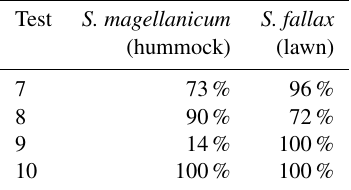
Table 4. Result from tests 7–10, which addressed the importance of meteorological fluctuations, the stochasticity of model parameters, and the photosynthetic water response. In Test 7, monthly mean val- ues of meteorological variables were used to drive the model simu- lation. In Test 8, the stochasticity of model parameters was removed, and the average values were used for parameters at the grid-cell level. In tests 9 and 10, the photosynthetic water-response parame- ters (i.e. a W0 , a W1 , and a W2 ; see Table 1) were set to be the same as those for S. magellanicum (Test 9) or the same as those for S. fallax (Test 10). The mean cover of S. magellanicum on hummocks and the cover of S. fallax on lawns after the 15-year simulation periods are listed in Table 4.